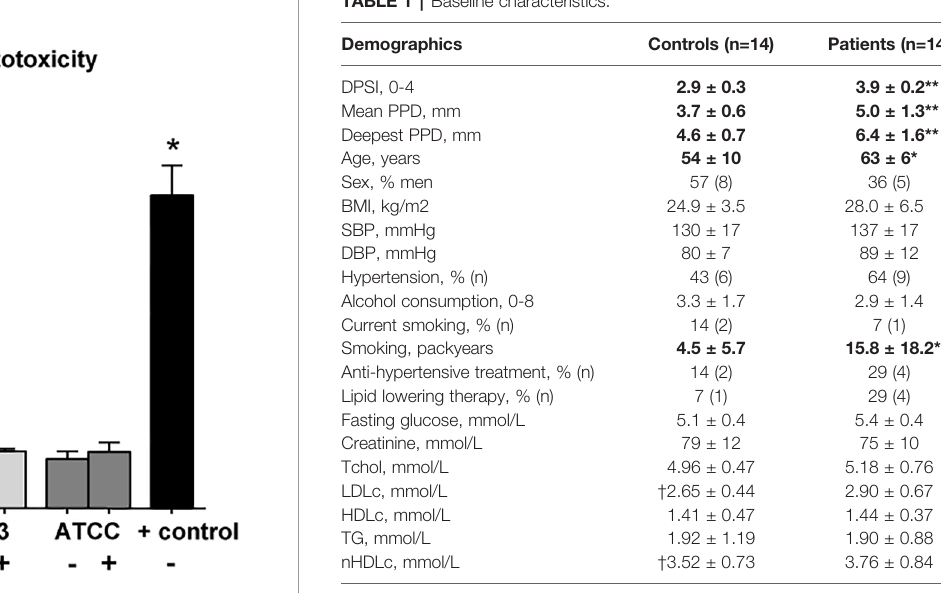
TABLE 1 | Baseline characteristics.